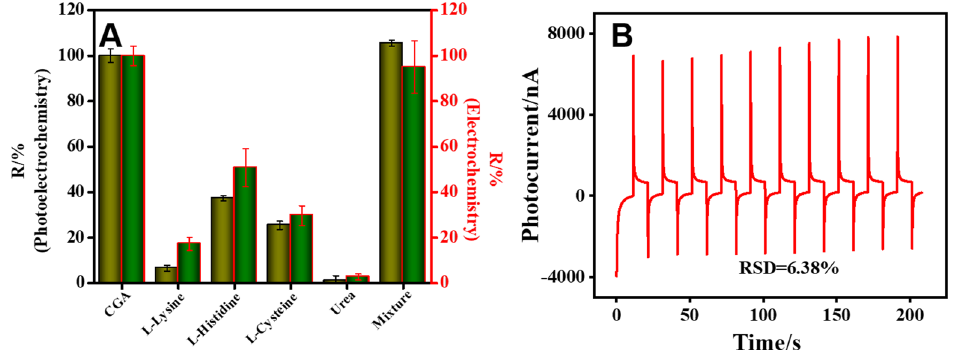
Figure 6. ( A ) Selectivity of the PEC/EC dual-mode sensor for CGA (2.825 × 10 − 7 mol L − 1 ) compared with interferences including L-Lysine, L-Histidine, L-Cysteine, Urea and their mixtures; ( B ) Stability